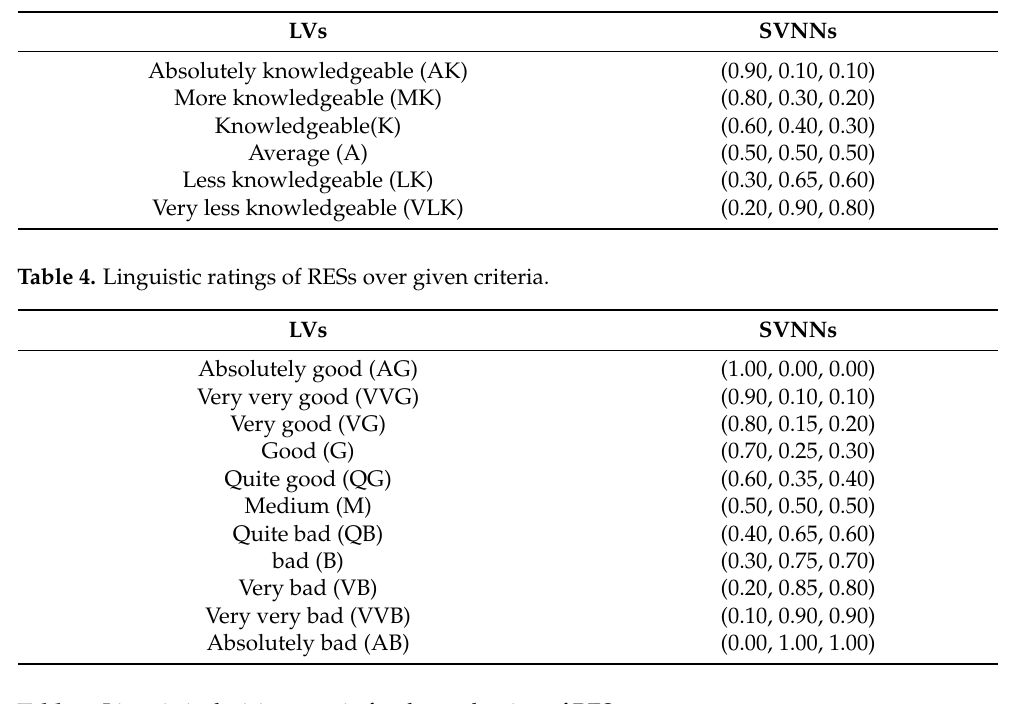
Table 5. Linguistic decision matrix for the evaluation of RESs.